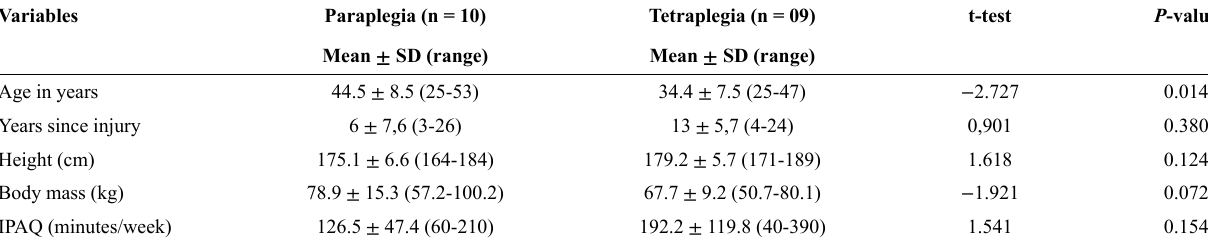
Table 1 - Characteristics of the